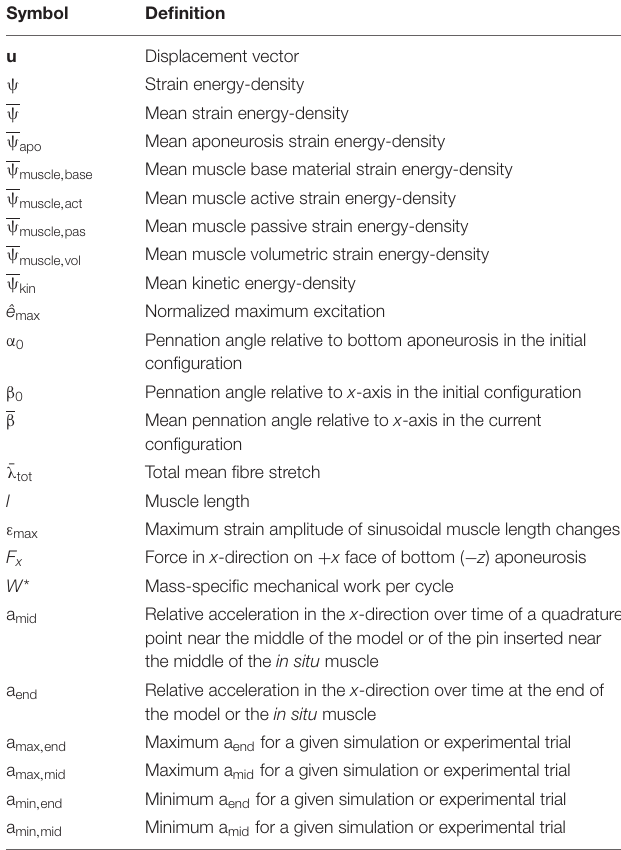
TABLE 1 | Symbols and definitions of variables in the main